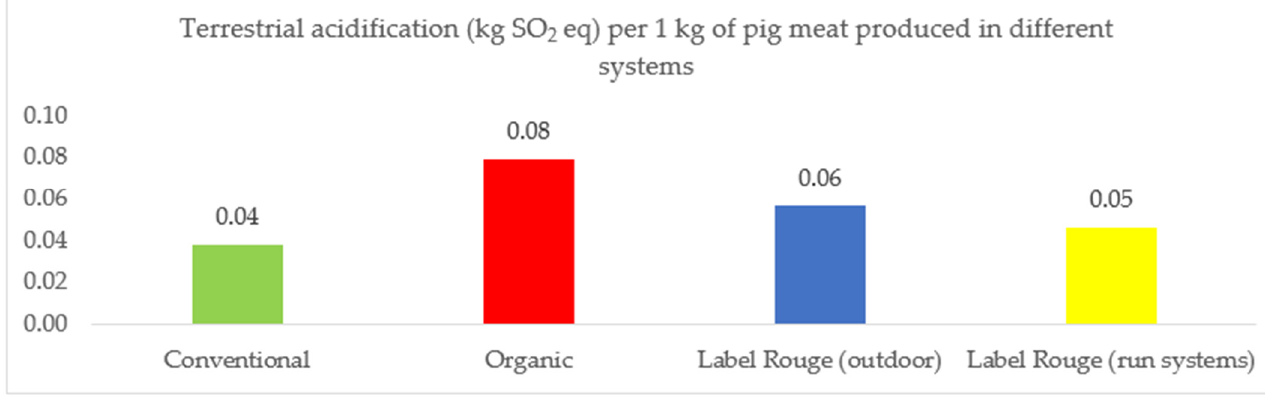
Figure 7. Terrestrial Acidification per 1 kg Pig meat across organic, Label Rouge and Conventional systems: Data obtained from AGRIBALYSE ® database and computed using OpenLCA 1.10.2 [35,36]. The Label Rouge (national standard outdoor system) had the best performance across